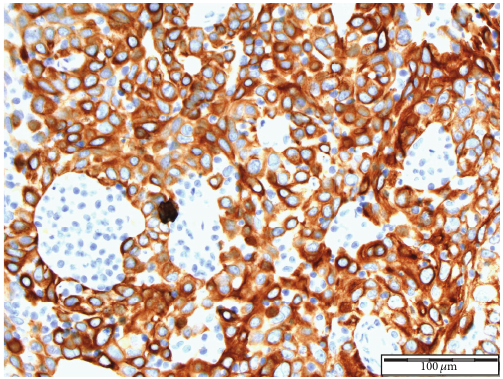
Figure 8: Immunohistochemical staining for p63 × 20 magnifi- cation. Lymphoepithelioma-like carcinoma of the urinary blad- der: the tumour cells stain positive with p63 in a background of inflammatory cells reproduced from [3]